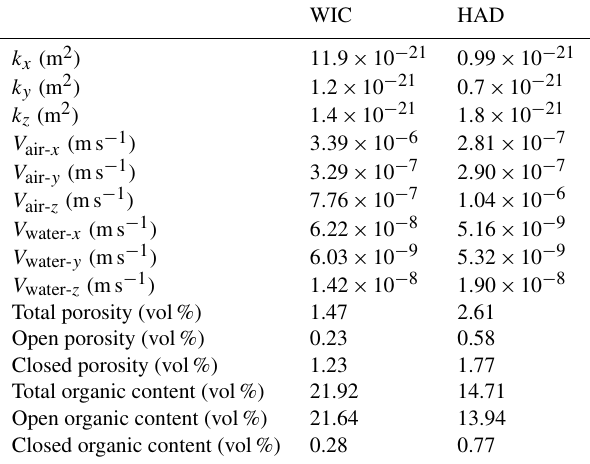
Table 2. Results of GeoDict permeability simulations and poros- ity analyses. Note that open and closed porosity calculations were performed on the binarized volumes including cluster sizes smaller than 10 voxels so summarized porosities may differ. ( k – permeabil- ity in x , y , z ; v – velocities for air and water flow in x , y , z ). WIC